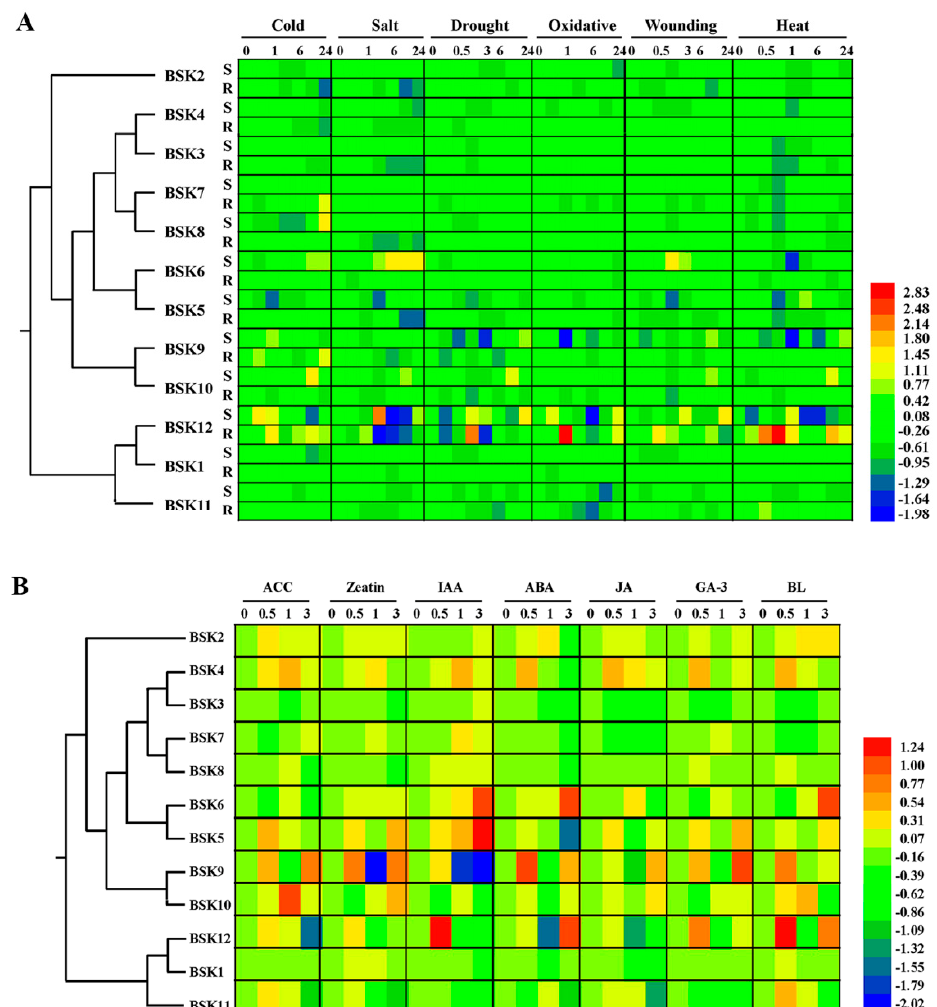
Figure 6. Expression patterns of all identified Arabidopsis BSK genes among hormone and abiotic stress. Public microarray data sets were obtained from BAR. Heat map representation the BSK genes under ( A ) six stress treatments, namely, cold, salt, drought, oxidative, wounding, and heat and ( B ) seven hormones, namely, ACC, zeatin, IAA, abscisic acid (ABA), methyl jasmonate (MeJA), gibberellic acid (GA-3), and brassinolide(BL). The colour bar represents the expression values.